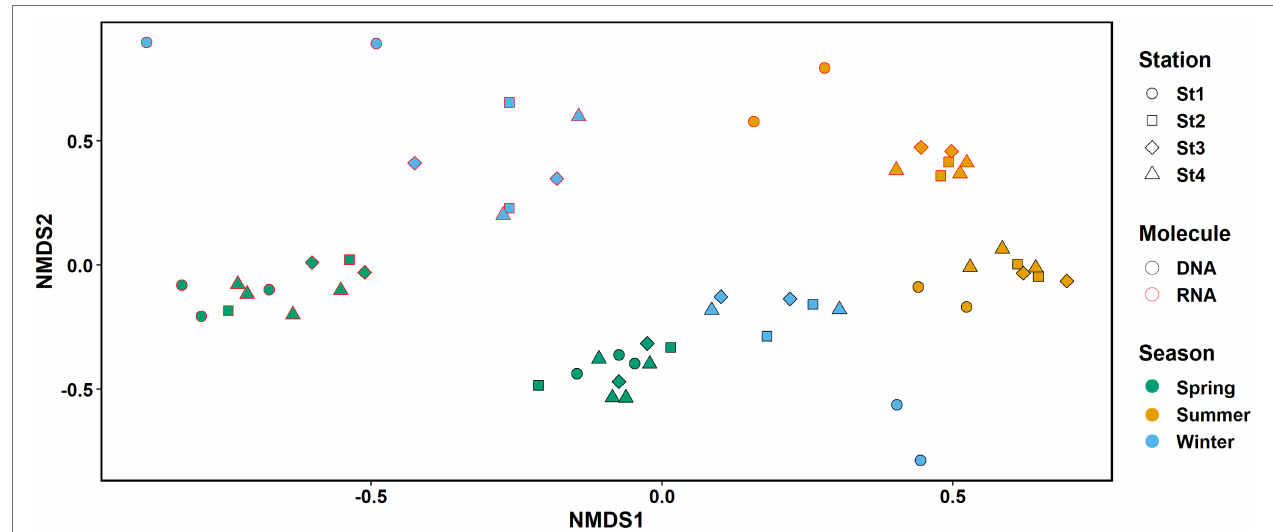
FIGURE 3 | NMDS plot of the RNA (red border) and DNA (black border) samples. Colors represent seasons: spring, green; summer, orange; and early winter, blue. Shapes represent different stations. K = 2, stress: